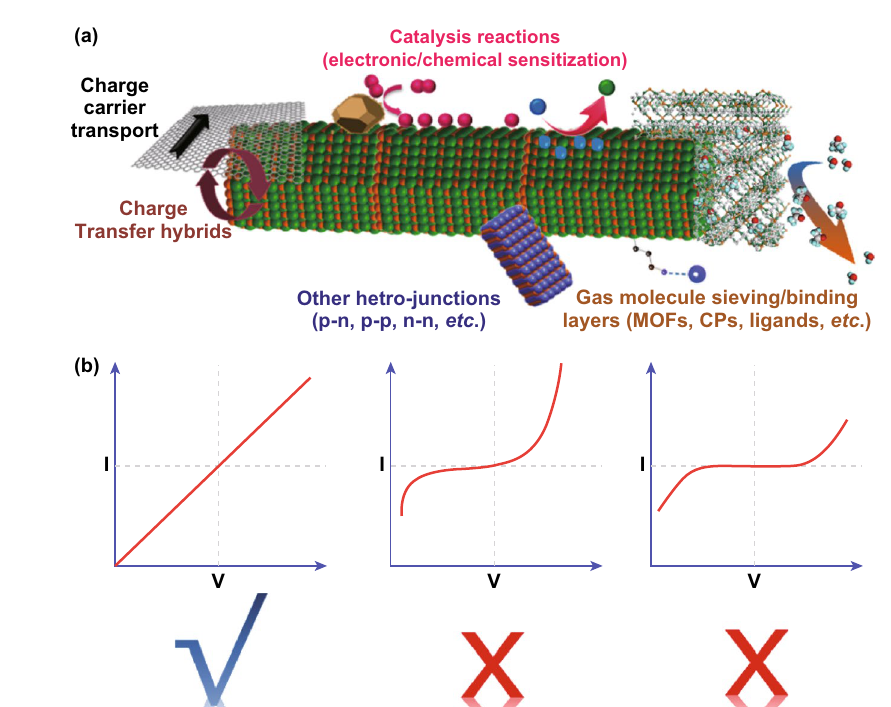
Fig. 2 a Schematic illustration of five typical forms of hybrid functional nanomaterials for chemi-resistive gas sensing; b typical I – V curves of different sensors under DC bias (from left to right, chemi-resistors, chemical diodes, and proton/ions